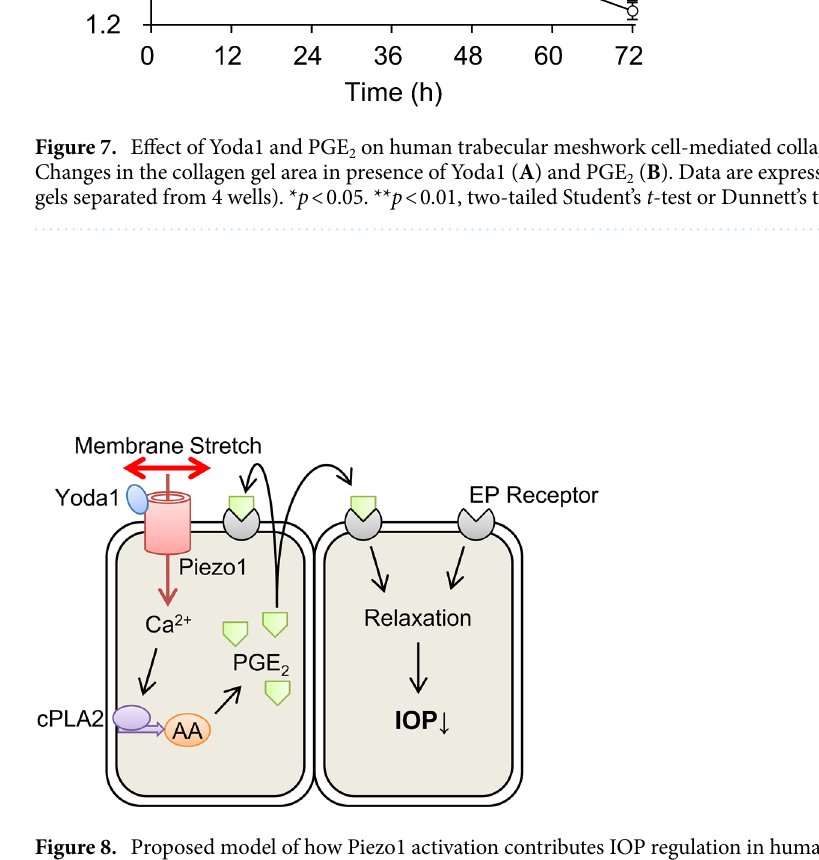
Figure 8. Proposed model of how Piezo1 activation contributes IOP regulation in human trabecular meshwork cells. Membrane stretch activates Piezo1 on hTM cells, causing Ca 2+ influx. This increase in intracellular Ca 2+ activates cytosolic phospholipase A2 (cPLA2) and releases arachidonic acid (AA) from membrane phospholipids. The liberated arachidonic acid is metabolized to produce PGE 2 , which causes cell relaxation via EP receptor, leading to a decrease in